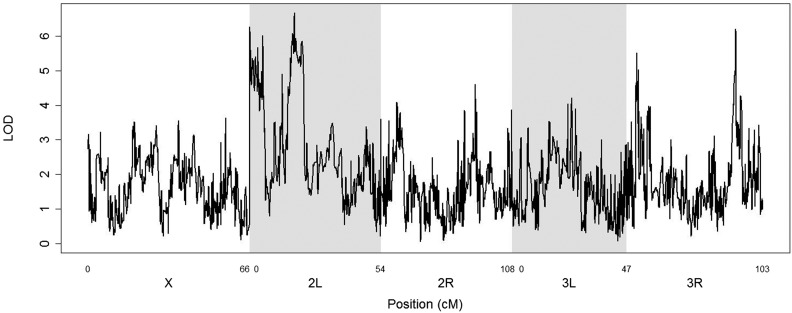
Genome scan of RIL pupal length in eight-way dataset (195 RILs means uncorrected for vial density). No peaks are significant at a P = 0.05 threshold of 7.02 LOD (estimated by permutation).